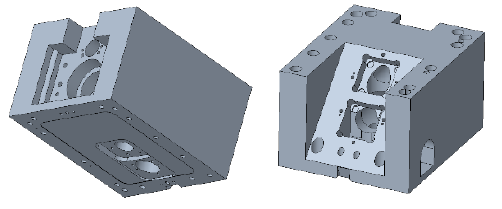
Fig. 1. CAD illustration of envelope model